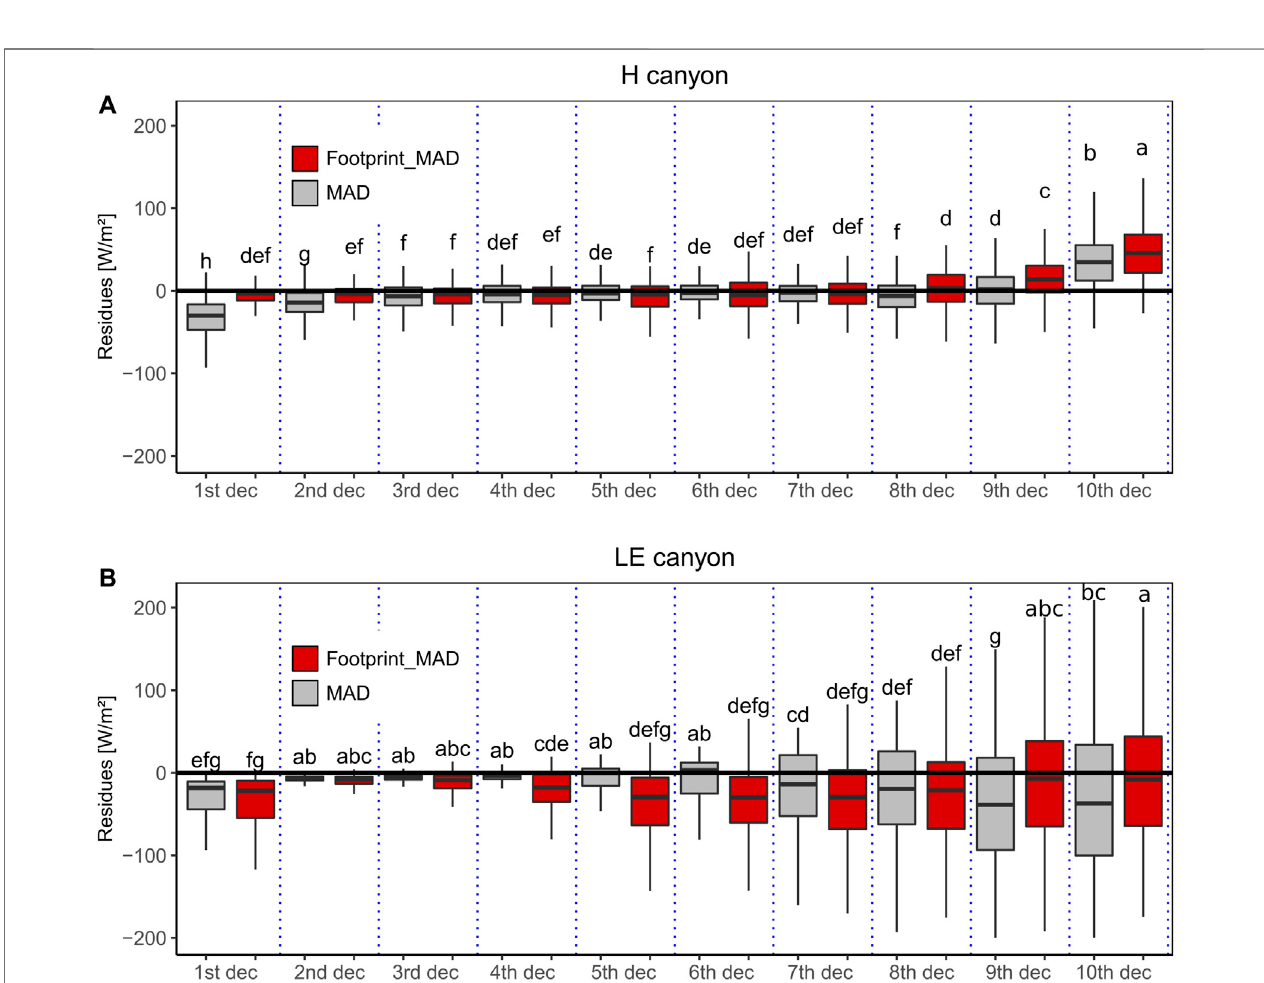
FIGURE6| Boxplotsoftheresidues fi lteredwiththeMAD(grey)andFootprint_MAD(red)methodsforeachdecileofthemeasurementsfor (A) Hand (B) LE fl uxes. Are also indicated the results from the pairwise comparison Turkey ’ s HSD statistical test (see text for details and explanations for the interpretation).